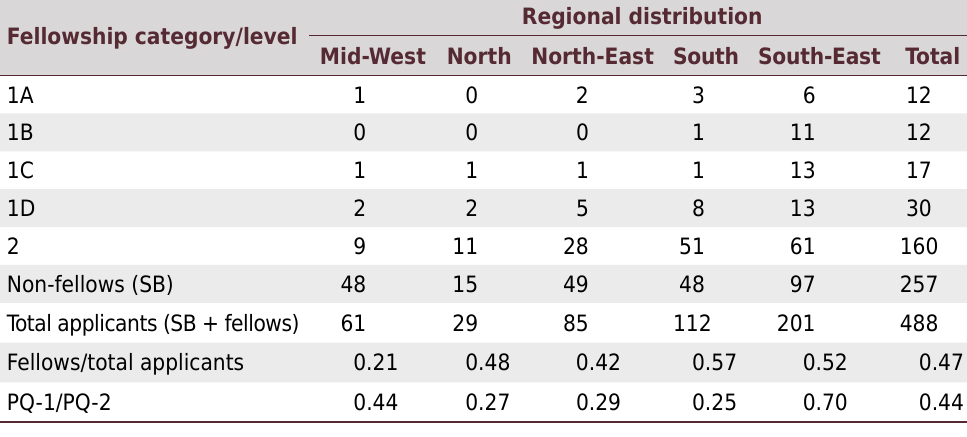
Regional distribution